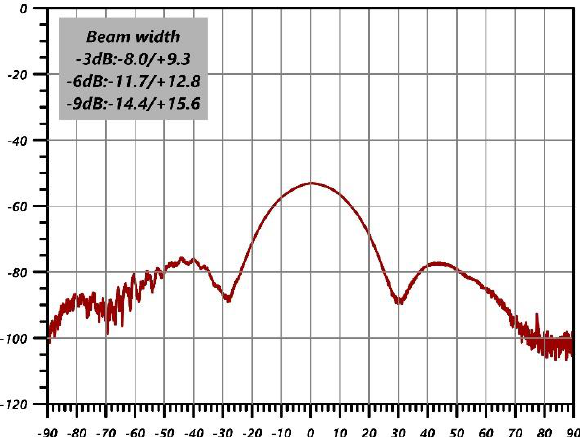
Figure 11. Antenna pattern of the developed Ku band